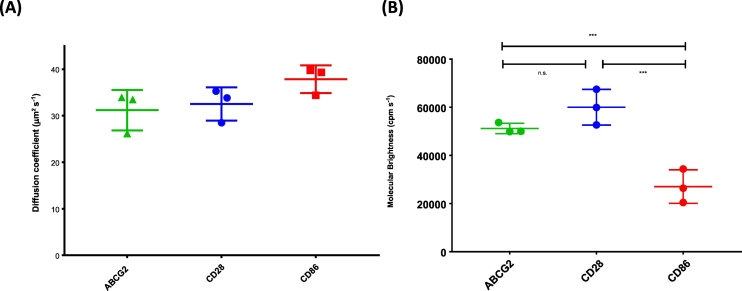
Particle diffusion and brightness analysis by FCS and PCH analysis. (A) The diffusion coefficients of SMALP encapsulated ACBG2 and control proteins CD28 and CD86 were determined by 2-component fitting of the autocorrelation curve (Fig. 2B). The diffusion coefficients of the predominant component (C1; Table 2) in each case were not statistically different to each other. (B) The molecular brightness of the predominant component in PCH analysis of ABCG2 was equivalent to that of the dimeric control (CD28) and approximately double that of the monomer control (CD86). Data represent the mean ± SD of three independent experiments each consisting of 3 measurements and significance is shown following one way ANOVA and Sidak post-analysis.